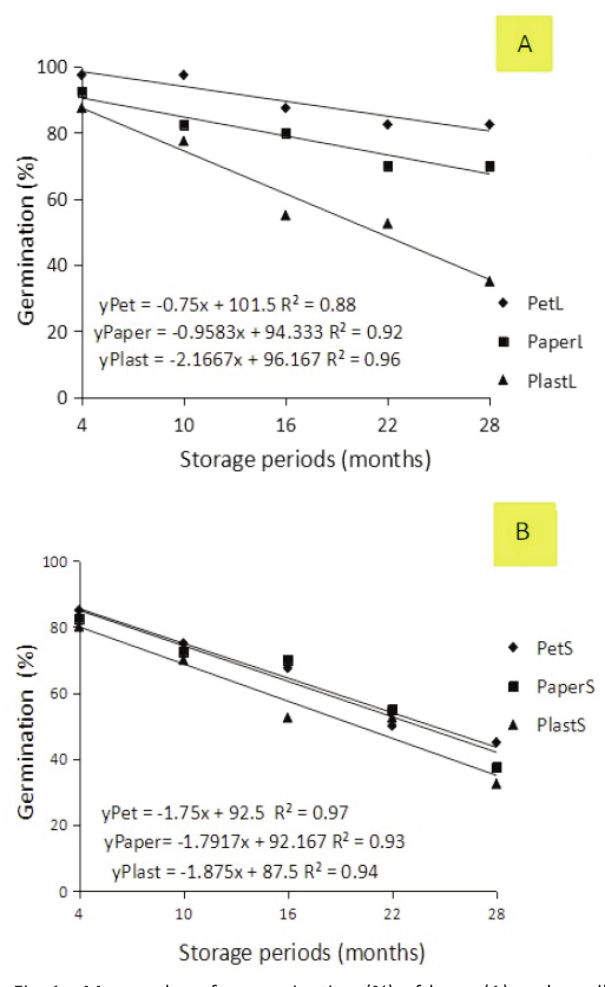
Fig. 1 - Mean values for germination (%) of large (A) and small (B) seeds of Pochota fendleri for different packaging and storage periods (months). Pet L= Pet bottles, Large; Paper L= Paper bags, large; Plast L= transparent plastic containers, Large; Pet S= Pet bottles, Small; Paper S= Paper bags, Small; Plast S= transparent plastic contai- ners,